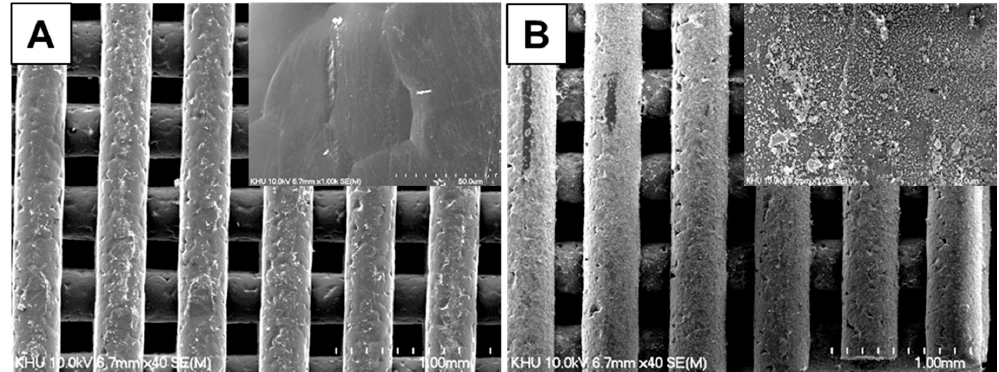
Figure 2. Scanning electron microscopy (SEM) images of β -cyclodextrin ( β CD)-grafted hydroxyapatite (HAp)-coated poly( ɛ -caprolactone) (PCL) scaffolds ( A ) without and ( B ) with adamantane (AD) grafting.